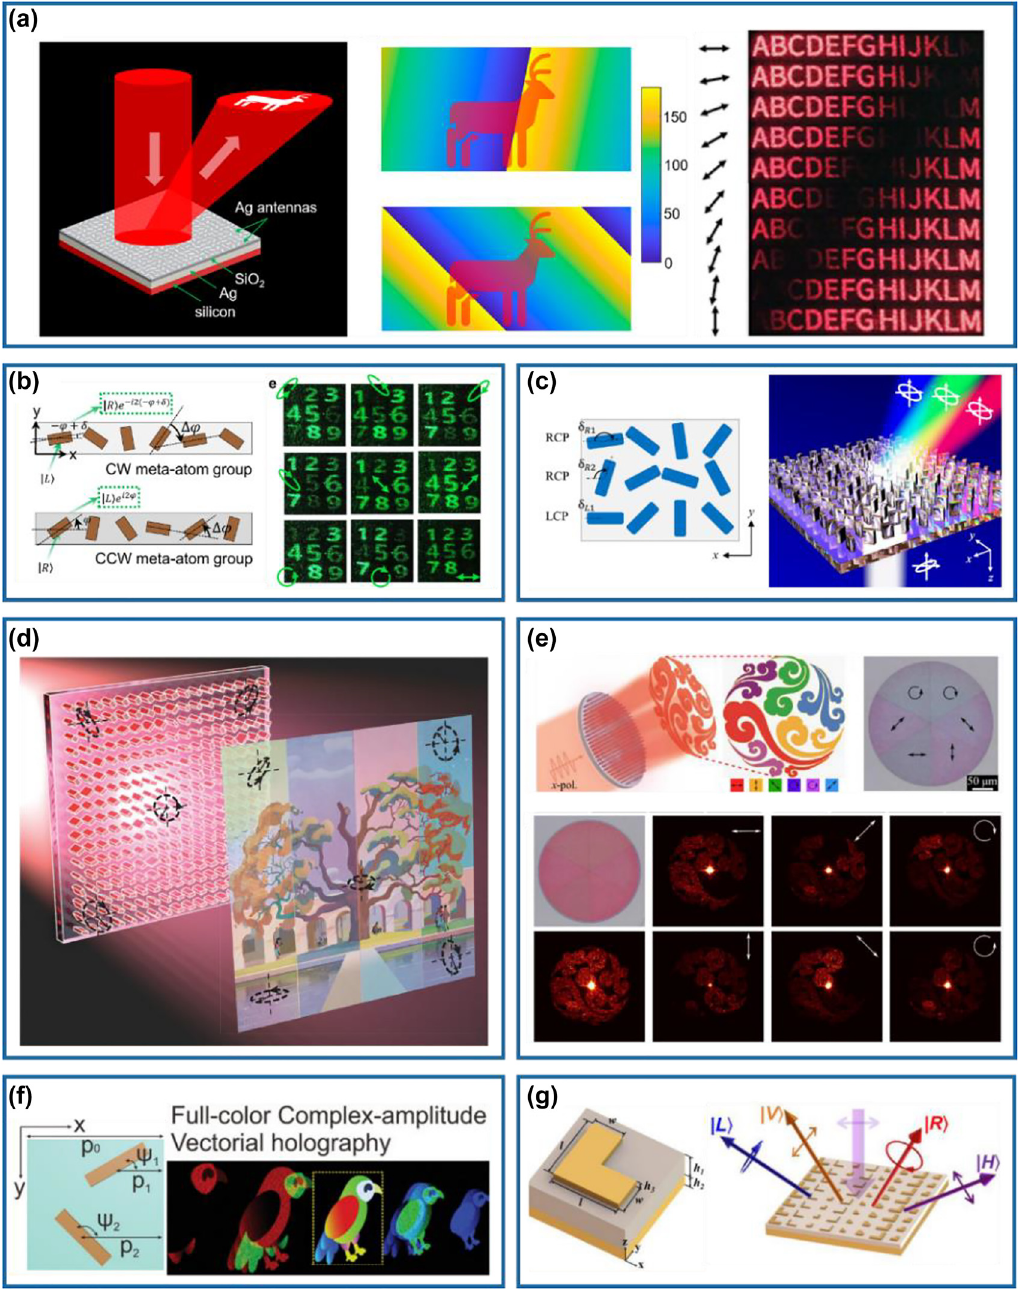
Figure 8: Optical meta-waveplate for all-polarization generation. (a) Left panel: schematic of the metasurface that generates the holographic patternwithcontinuouspolarizationdistributions.Middlepanel:holographicimage(deerpattern)withdifferentpolarizationmapsbyaslight adjustment of the supercell structure of the metasurface. Right panel: reconstructed holographic images for different polarization directions at λ =635 nm.Reprinted fromRef. [113]. (b)Left panel:two typesof meta-atomgroupsto generateoutgoing RCPandLCP with arbitraryphase. Right panel: experimental demonstration of the hologram images carrying nine different polarization states. Reprinted from Ref. [114]. (c) Broadband polarization-maintaining design with a uniform size metasurface. Reprinted from Ref. [115]. (d) Schematic of a metasurface polarization hologram that encodes a polarization pattern into an RGB image. Reprinted from Ref. [116]. (e) Top left panel: schematic of the vectorial holographic display, where the holographic image with spatially-varying polarization states is generated with an x -polarized light. Topright panel:opticalimageof the fabricatedmeta-hologram.Bottompanel:measuredholographicimages byilluminatingthe wholemeta- hologramwith an x -polarized waveat λ = 850nm. Reprintedfrom Ref. [118]. (f) Left panel:wavelength/angle-independentphase modulations with a diatomic meta-molecule that provides the geometric and detour phases with freely controllable orientations and displacements. Right panel: schematic of the full-color complex-amplitude vectorial meta-hologram. Reprinted from Ref. [120]. (g) Left panel: schematic of the L-shaped MIM meta-atom. Right panel: schematic of the metasurface generating two linear polarization and two circular polarization states. Reprinted from Ref.